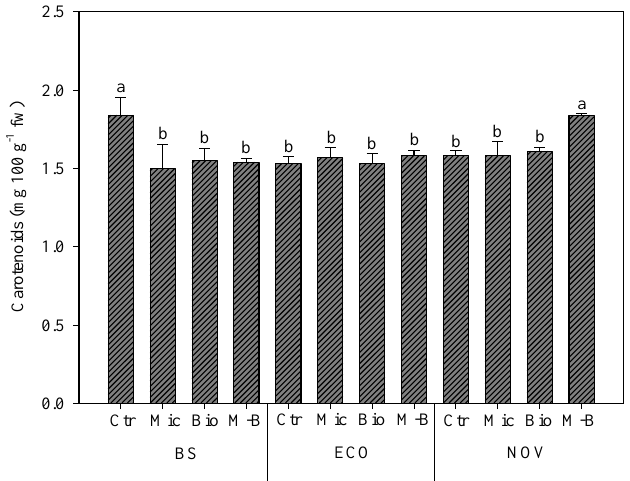
Figure 3. Carotenoid content of tomato fruits as affected by the interaction mulching (ECO: biodegrad- able film Ecovio; NOV: biodegradable film MaterBi ® ; BS: bare soil) and biostimulant application (Bio: treated with Phylgreen ® ; Mic: treated with Trianum-P ® ; M-B: combination of Bio and Mic; Ctr: not treated). Each column indicates the mean value of the three replicates. Vertical bars indicate standard error; different letters indicate significant differences according to Tukey’s test ( p < 0.05).